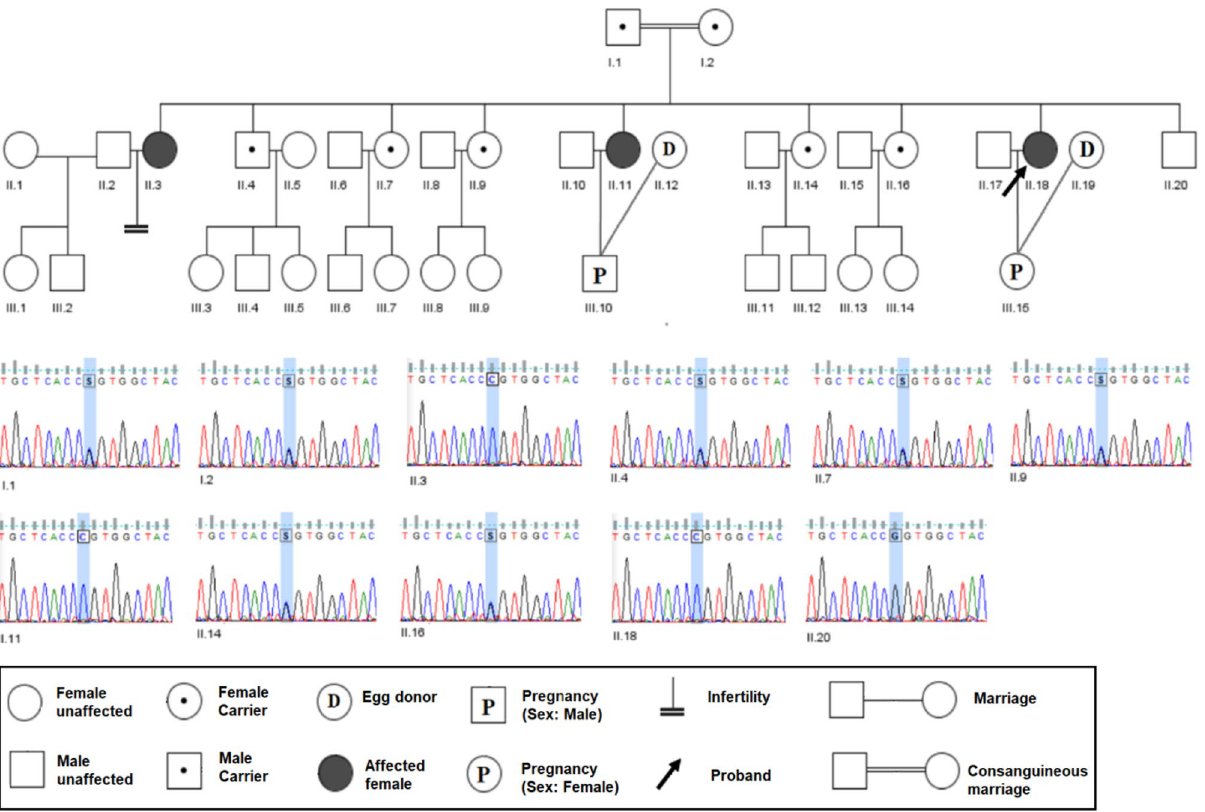
Figure 1. Pedigree of the studied family. Identification of TLE6 variant in affected individuals and other family members. ( TLE6 : NM_001143986: exon13: c. G1054C: p.